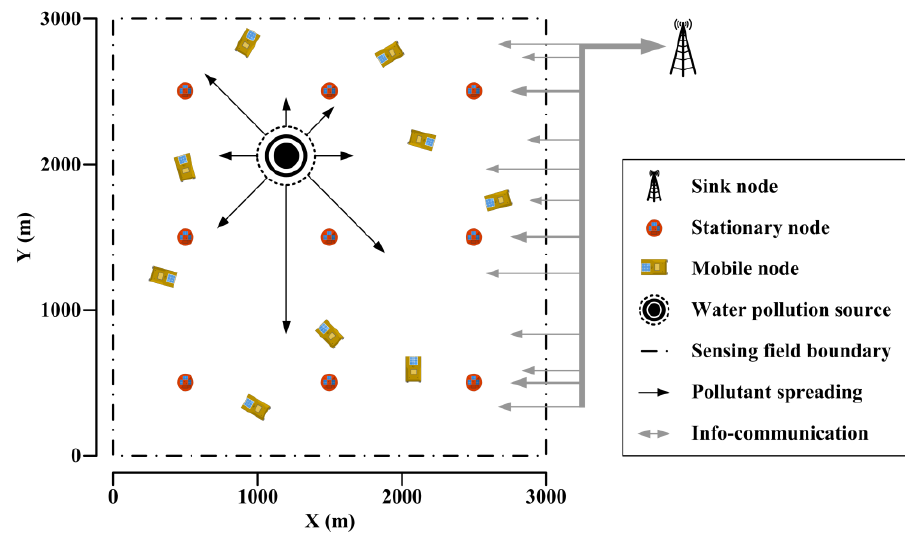
Figure 4. The WSN deployment for water quality monitoring.